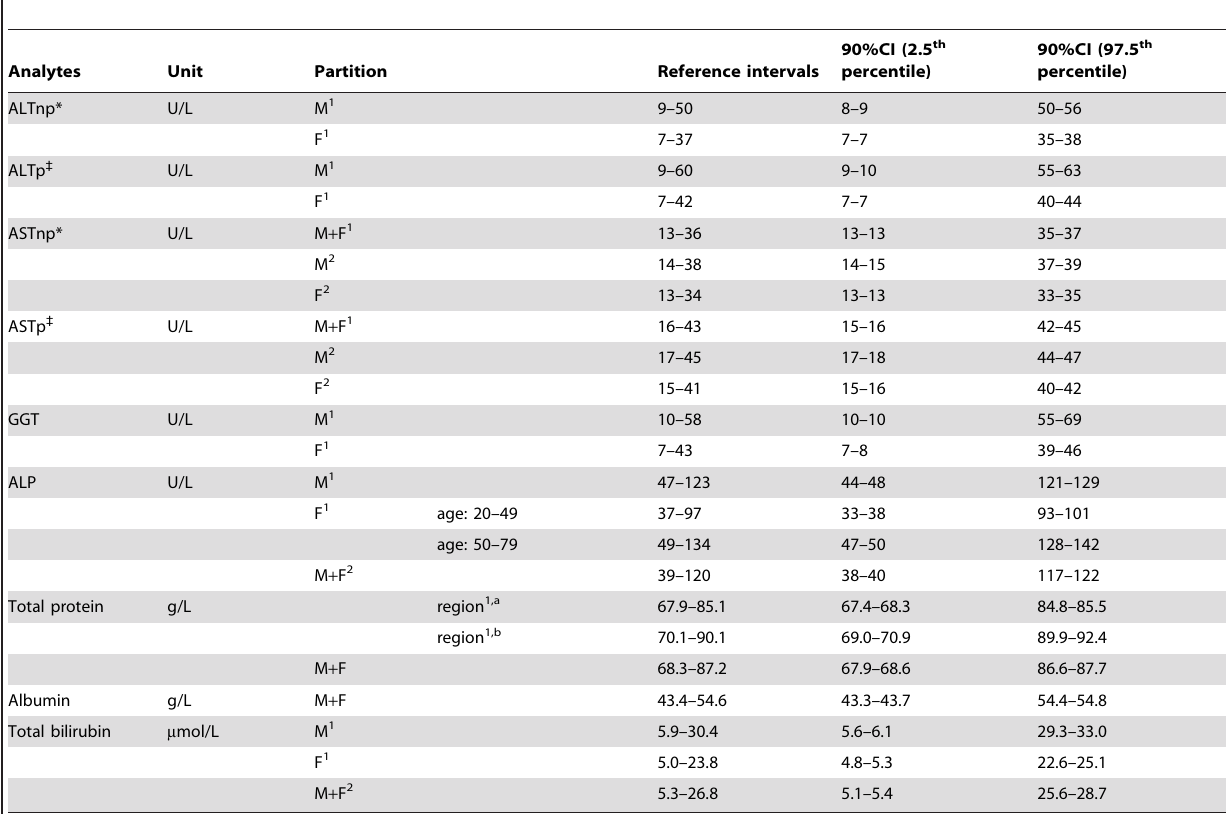
Table 3. Reference intervals of liver function tests of the adult population in China.